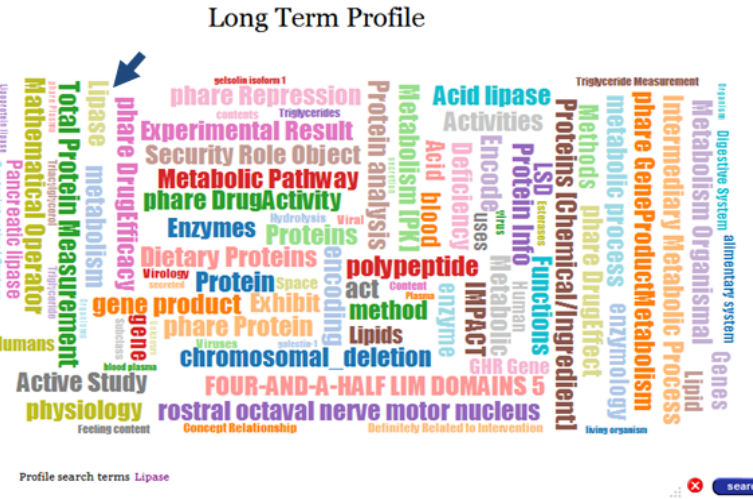
Figure 6. Selected search term in the Long Term Profile.